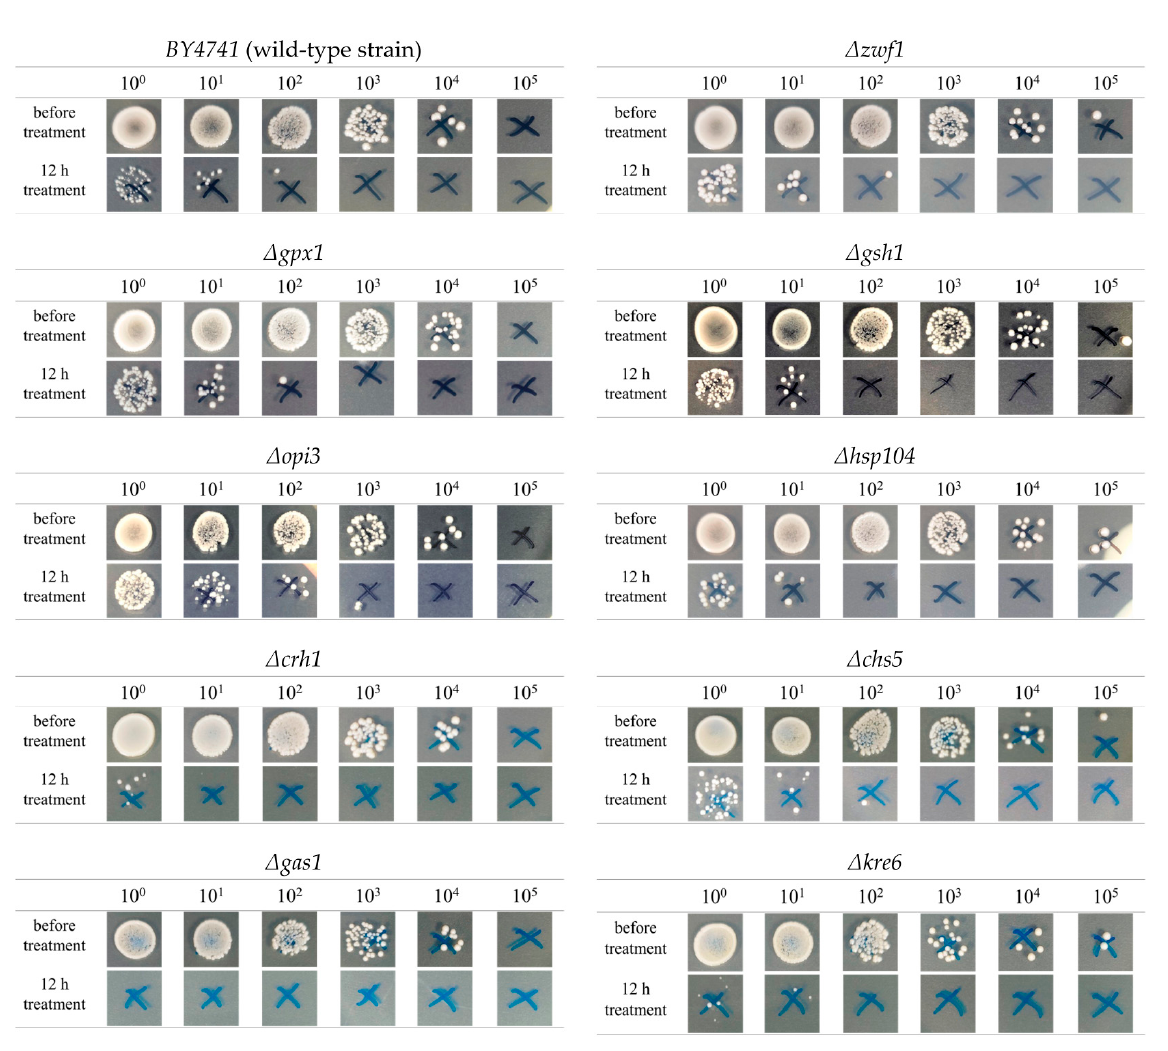
Figure 3. Different strains’ spot assays before treatment and after 12 h HPCD treatment (4.0 MPa, 30 °C). X axial shows the dilution ratio. Y axial shows treatment condition. Different strain names are presented on the top of each group of the spots’ results.